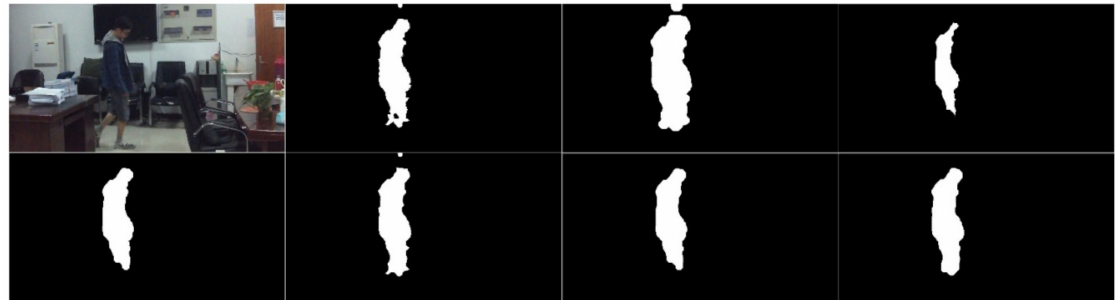
Figure 4. From left to right, top to bottom: Current frame image, moving target foreground area extracted by the optical flow method with Otsu binarization, target foreground area extracted by expansion operation, corrosion operation, open operation, closed operation, first open then close operation, and first close then open